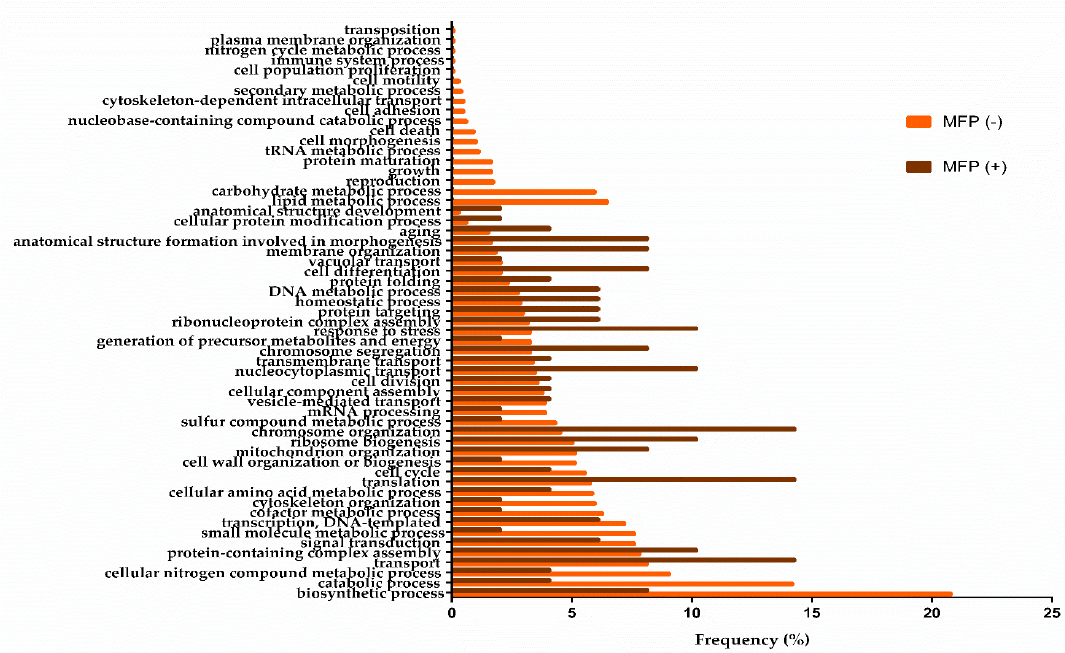
Figure 2. Relevant biological processes in middle of second fermentation without CO 2 overpressure (MFP ( − ) in orange), and with overpressure (MFP (+) in brown). The frequency (%) of each process corresponds to the number of proteins involved in each process with respect to the total proteins identified.